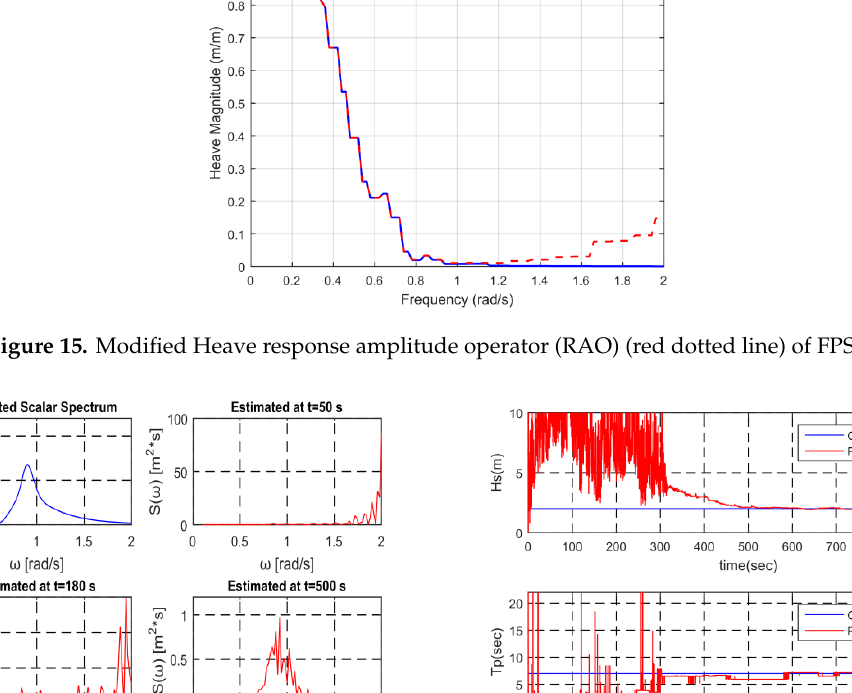
Figure 14. Comparison of Image Restoration and Wave Estimation.